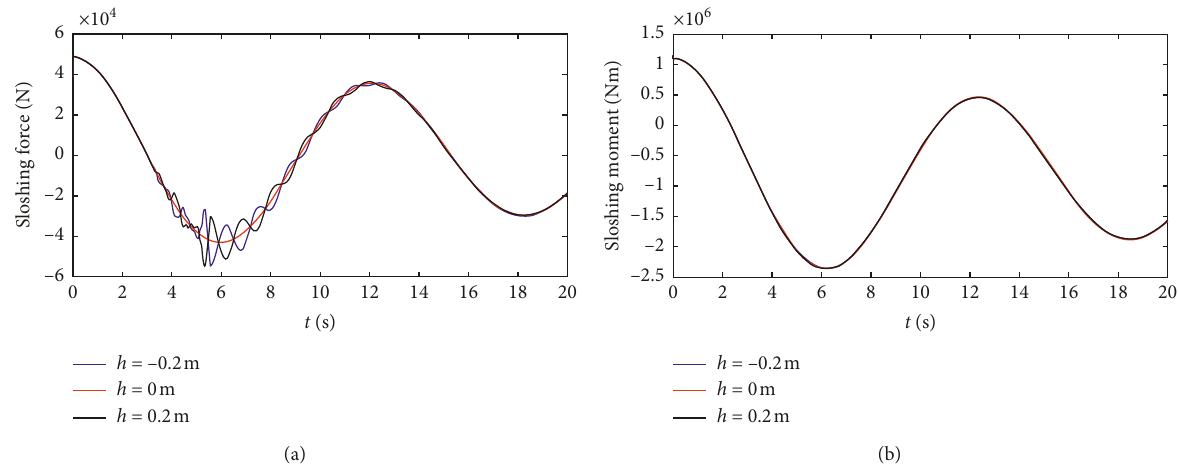
Figure 15: Sloshing force and moment during vehicle acceleration for a � 0 . 2 g